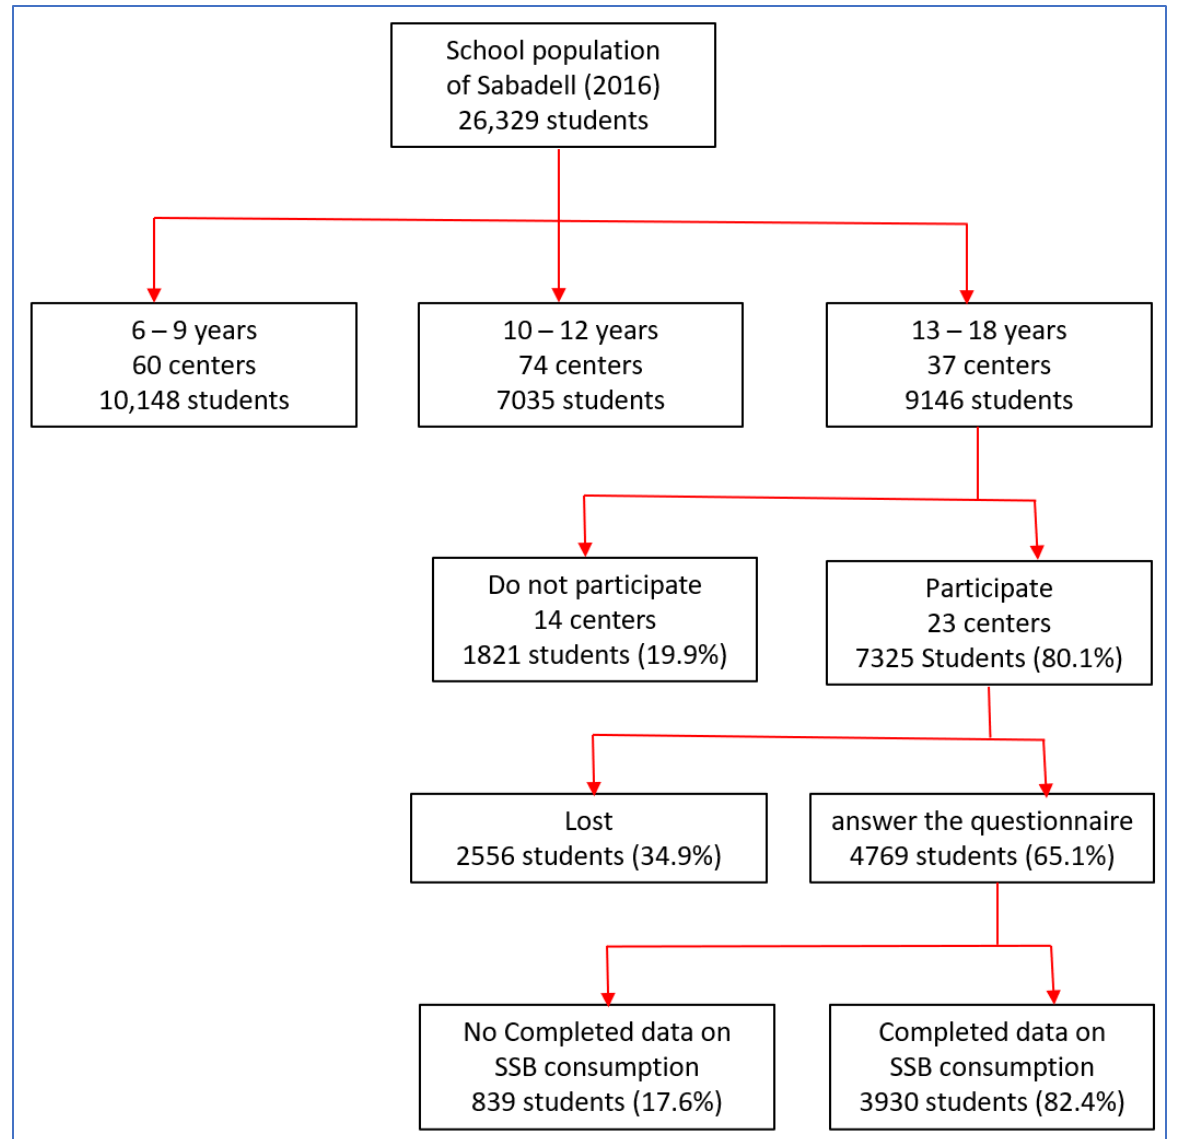
Figure 1. Participation flow chart from Beenis Study. This diagram shows the flow of participants in this article. Initially, all schools in Sabadell were invited to participate ( n = 26,329 students). In the group of 9146 students between 13–18 years, 23 centers with a population of 7325 students agreed to participate, of which 4769 answered the questionnaire and 3930 had Completed data on SSB consumption. SSB: sugar-sweetened beverages